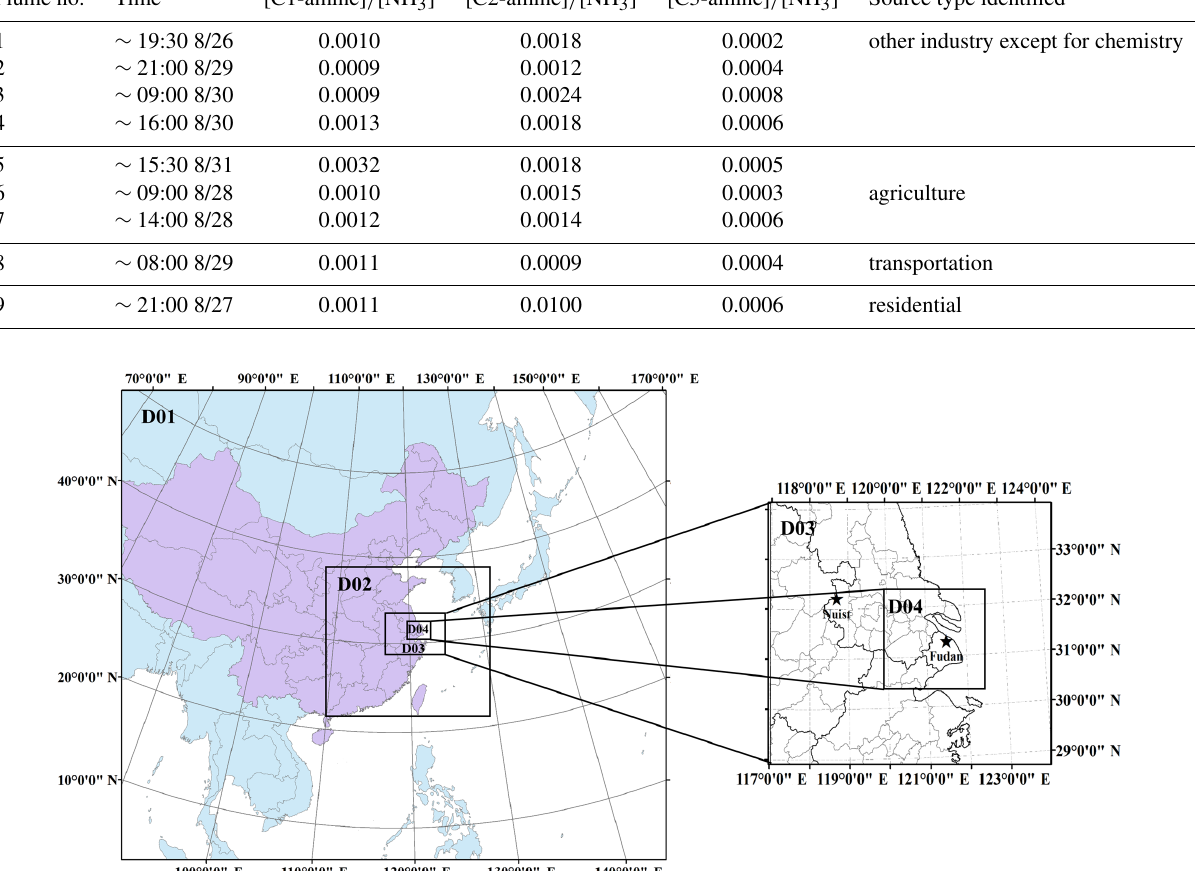
Table 1. The ratios of C1-, C2-, and C3-amines to that of ammonia from the peak values of individual plumes with different origins, derived from measurements taken at a suburban site of Nanjing as reported in Zheng et al. (2015). Plume no.